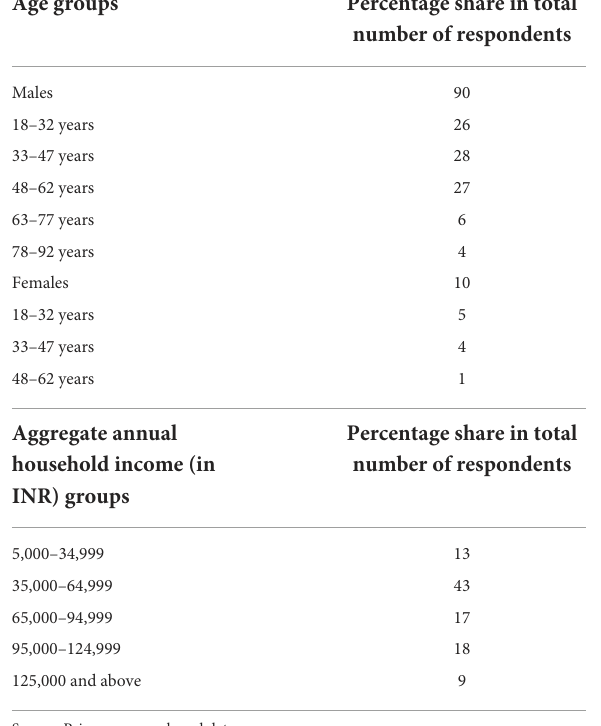
TABLE 8 General information about the respondents of primary survey in the study site.